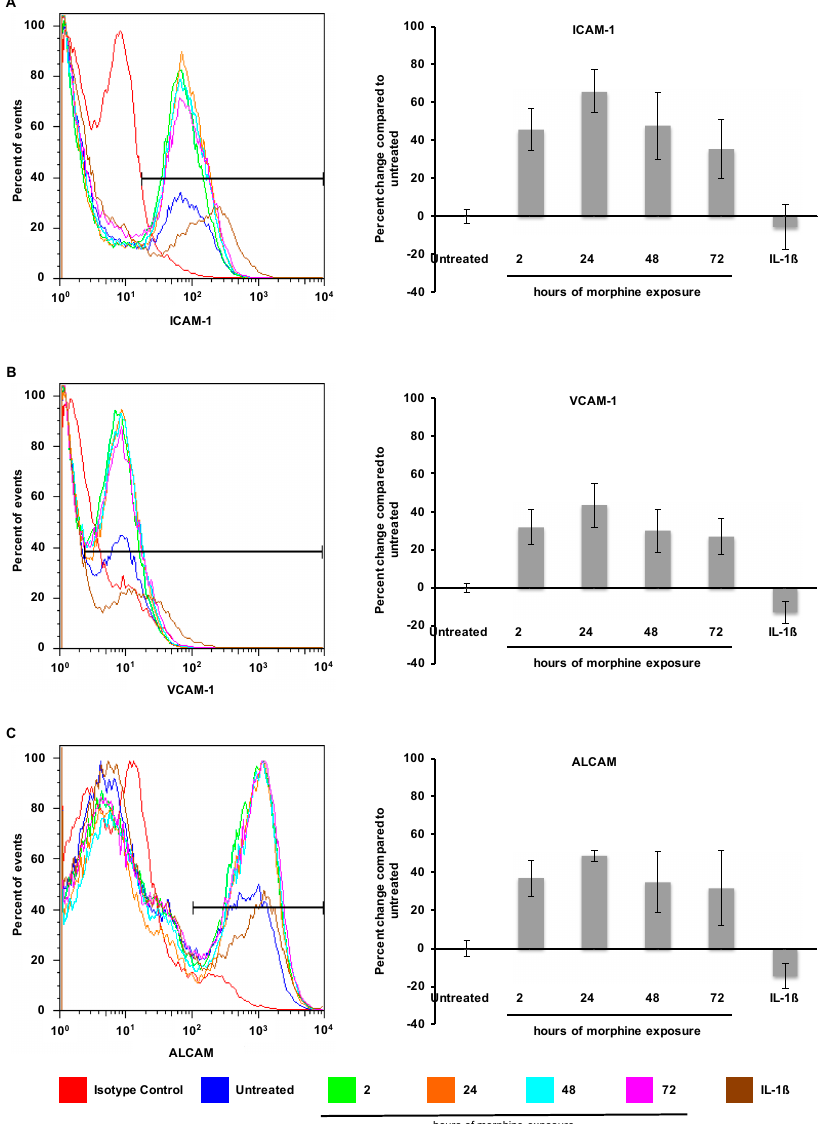
Figure 3. Morphine increased cell surface expression of intercellular adhesion molecule-1 (ICAM-1), vascular cell adhesion molecule-1 (VCAM-1), and activated leukocyte cell adhesion molecule (ALCAM). Exposure to morphine (0.1 µM) for 2, 24, 48, and 72 h increased the number of hCMEC/D3 cells expressing ICAM-1 ( A ); VCAM-1 ( B ); and ALCAM ( C ) on the cell surface as determined by flow cytometry on nonpermeabilized hCMEC/D3 cells (panels on left). The levels of expression in untreated cells are shown in blue; individual isotype controls are shown in red for each antibody treatment. A range gate, as shown in these histograms, was used to quantitate the number of cells within a given fluorescence intensity (FI) range. Treatment with IL-1 β (20 ng/mL) for 24 h induced an increased level of ICAM-1, VCAM-1, and ALCAM expression (compare the blue and brown lines in the left panels), while it slightly decreased the number of cells expressing the proteins on the cell surface (right panels). Quantitation of hCMEC/D3 cells expressing ICAM-1 ( A ); VCAM-1 ( B ); and ALCAM ( C ) is shown as the percent change in the number of expressing cells as compared with untreated controls (panels on right). The untreated control is shown as 0% change. All bars represent average percent change in the number of cells compared with the untreated control. All bars represent three independent experiments performed in triplicate. p < 0.001 for all treatment conditions compared with untreated controls by Student’s t -test